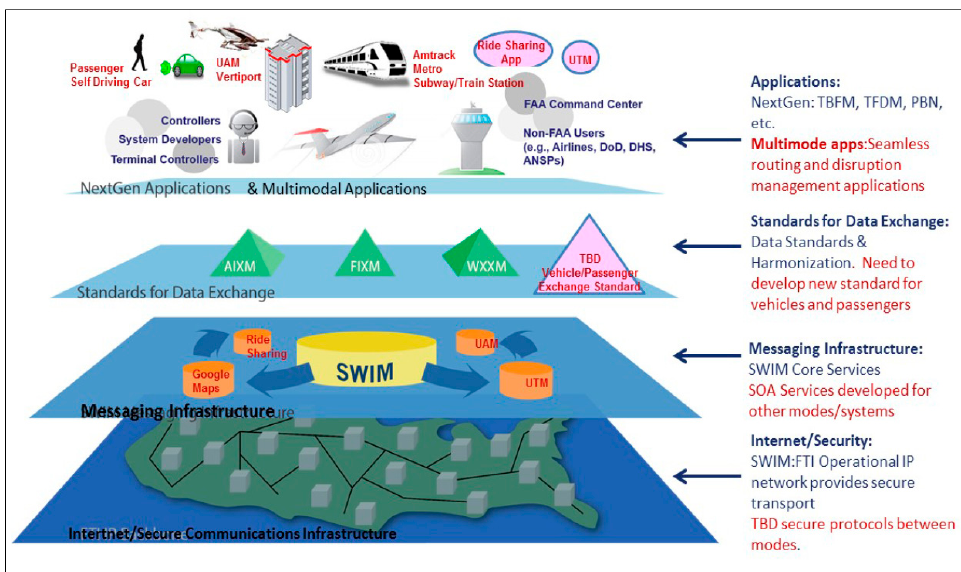
Figure 7. Seamless Mobility Information Sharing Architecture. Reproduced from Tuchen et al. [27].